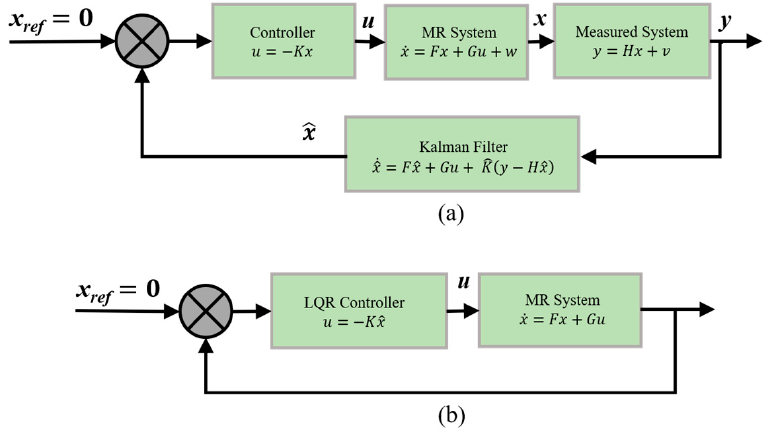
Figure 6. Block diagram of ( a ) LQG and ( b ) LQR [26]. Reproduced with permission from Choi, S.-B. et al. State of the art of control schemes for smart systems featuring magnetorheological materials; published by Smart Materials and Structures, 2016.